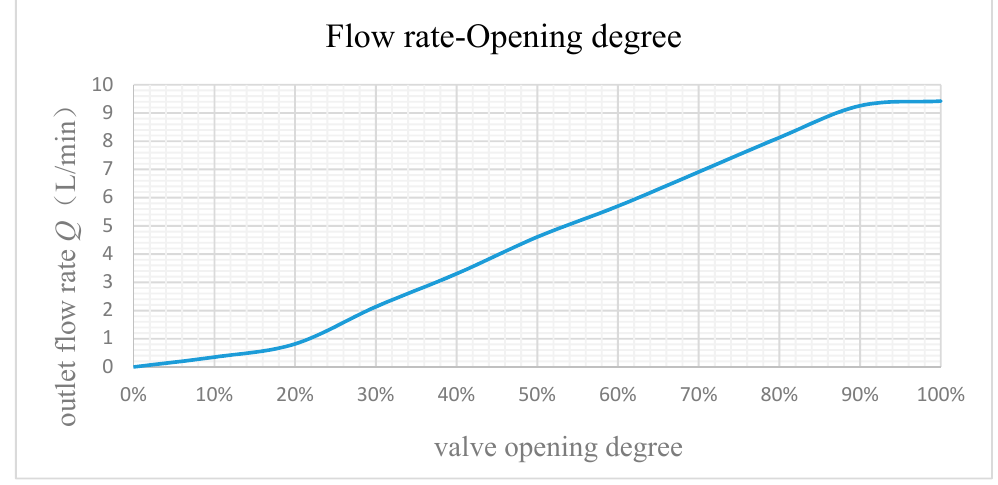
Figure 19. The results of the flow characteristics at different openings of profile F.